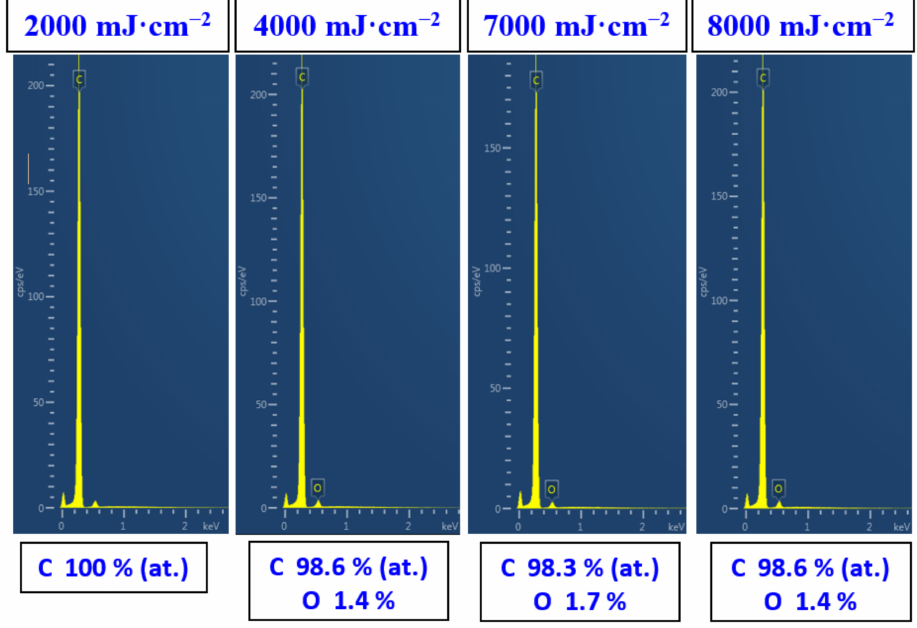
Figure 4. Energy dispersive spectra of carbon sheets exposed with high energy excimer laser and laser fluencies from 2000 to 8000 mJ · cm − 2